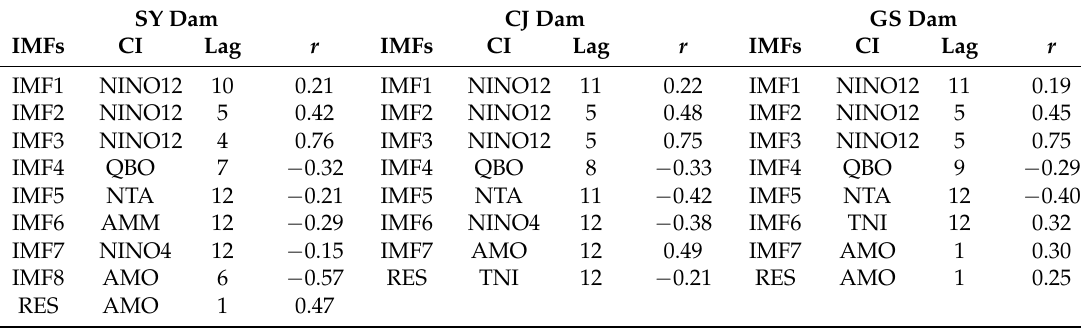
Table 4. Correlation coefficients ( r ) between the intrinsic mode functions (IMFs) and the lagged climate indices in the SY, CJ, and GS